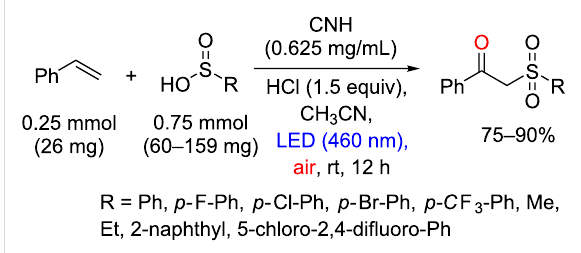
Scheme 19: Sulfonic acid scope of the sulfonation